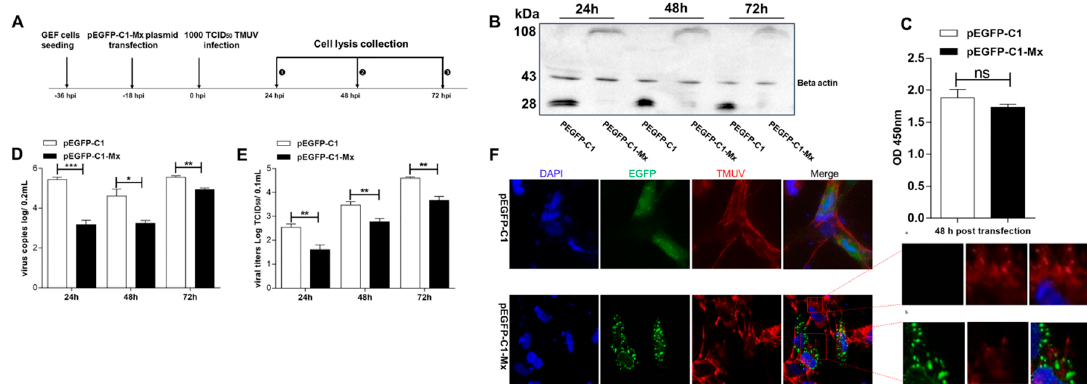
Figure 5. The pronounced inhibition of TMUV replication in GEF-expressing EGFP fusion goMx. ( A ) Experimental procedure of the antiviral test. ( B ) Detection of pEGFP fusion Mx protein by western blot analysis. Cell extracts were prepared, and samples of 15 µ L of protein per lane were separated by SDS-polyacrylamide gel electrophoresis. ( C ) Viability of GEF cells transfected with pEGFP-C1 and pEGFP-C1-Mx. GEF cells were grown in a 96-well plate and transfected with pEGFP-C1 and pEGFP-C1-Mx. After 48 h, the cell viability was determined by CCK8 assay. Data are expressed as mean ± SD from three independent experiments. ( D ) Inhibition of TMUV genomic RNA by overexpressed pEGFP-C1-Mx. At 24, 48, and 72 hpi, infected GEFs were collected and lysed by three freezing–thawing cycles in a volume of 500 µ L cell culture supernatants. RT-qPCR was performed in triplicate, and data are shown as mean ± SD of three independent experiments ( p -value <0.05 and p -value <0.01 represent significant differences). ( E ) Inhibition of TMUV titers by overexpressed pEGFP-C1-Mx. The virus